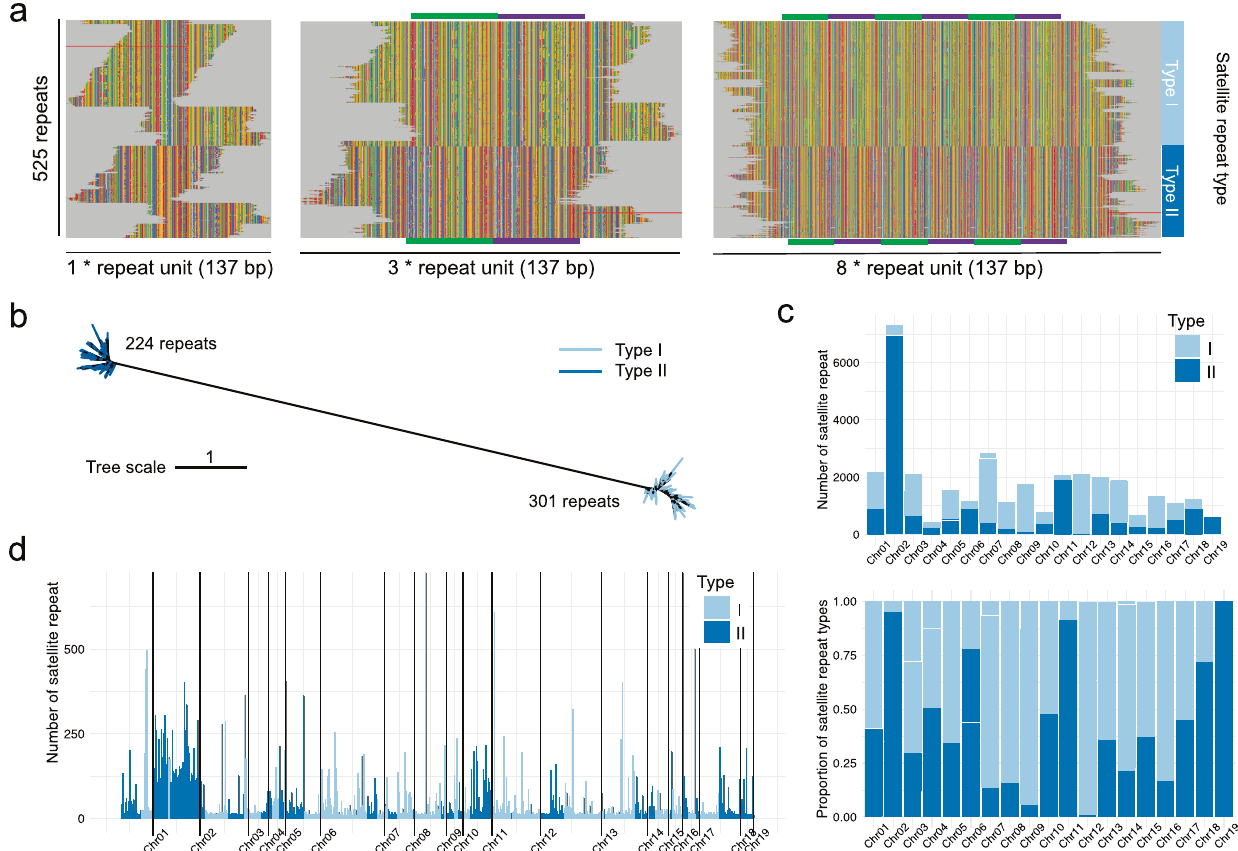
Fig. 2 Evolution of satellite repeats of M. lutarioriparius . a Multiple sequence alignment of 525 satellite repeats derived from screening the M. lutarioriparius genome sequence. One, three, and eight tandem satellite repeats were used to perform alignment, respectively. Here, 301 sequences were clustered into Type I satellite repeats and 224 into Type II satellite repeats. b Maximum likelihood tree of 525 satellite repeats. c Absolute and relative frequency distributions of Type II satellite repeats of each chromosome. d Copy number distribution of 525 satellite repeats, which is arranged according to the order on chromosomes. Source Data are provided as a Source Data fi